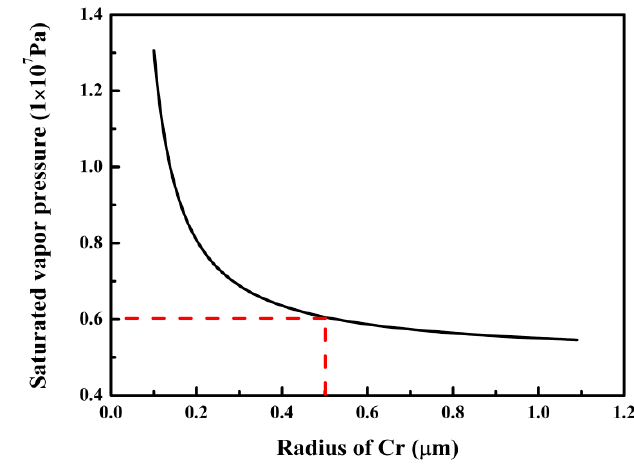
Figure 12. Relationship between saturated vapor pressure and the radius of Cr particles in Cu-Cr